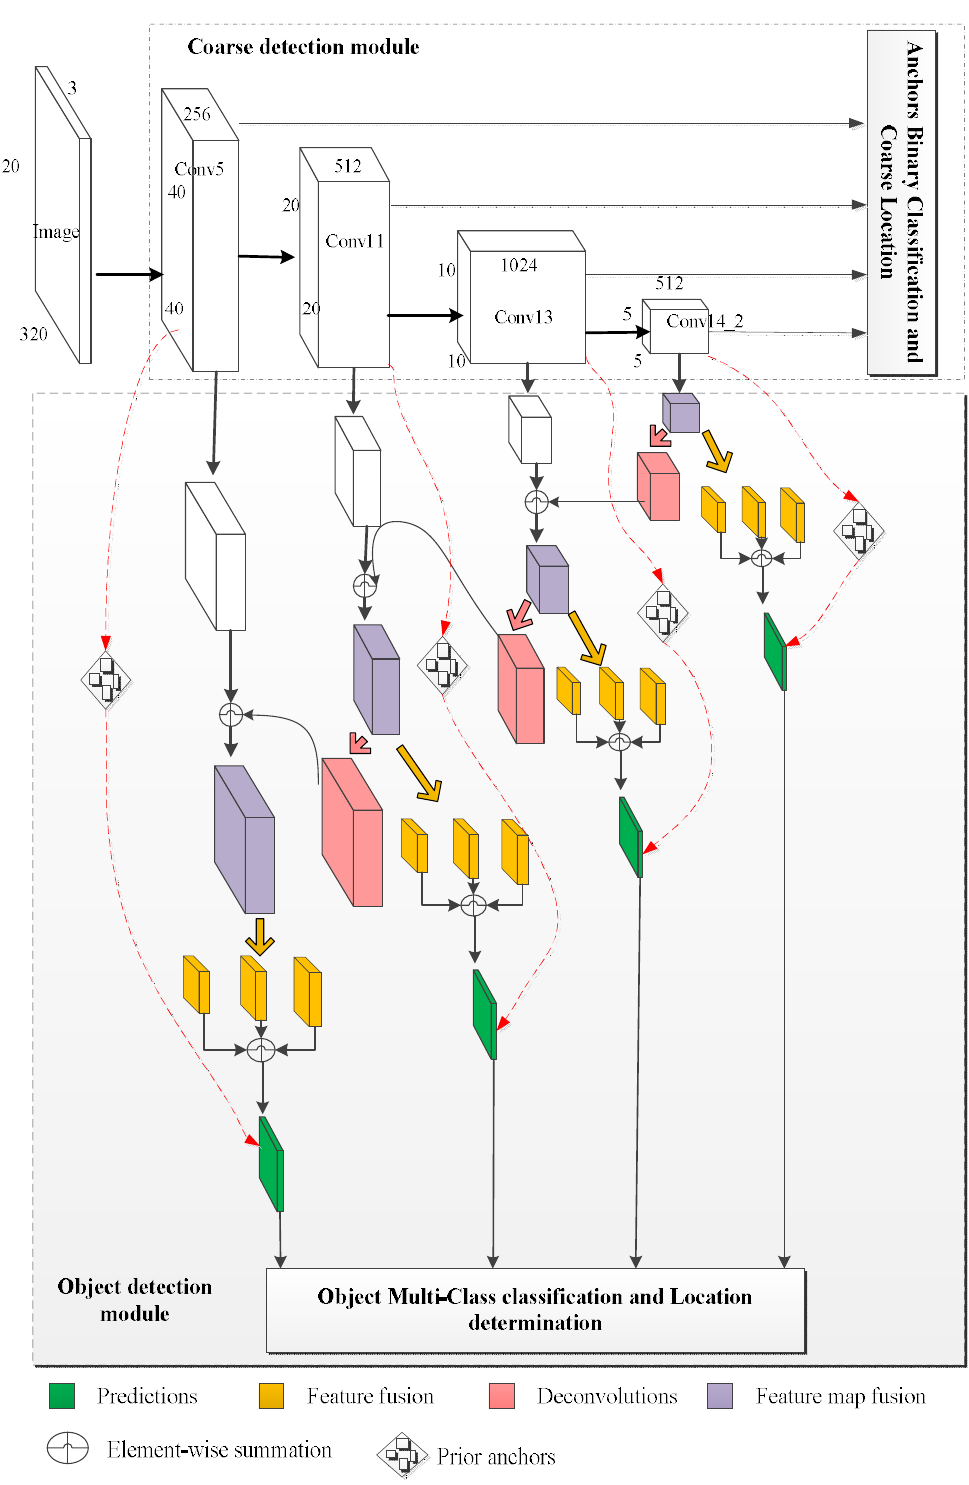
Figure 2. Feature Fusion Refine neural (FR-Net) architecture overview includes depthwise–pointwise convolutions, a coarse object detection module, and an object detection module. Predictions are carried out by four green layers with different scales. Different colors represent different function layers.